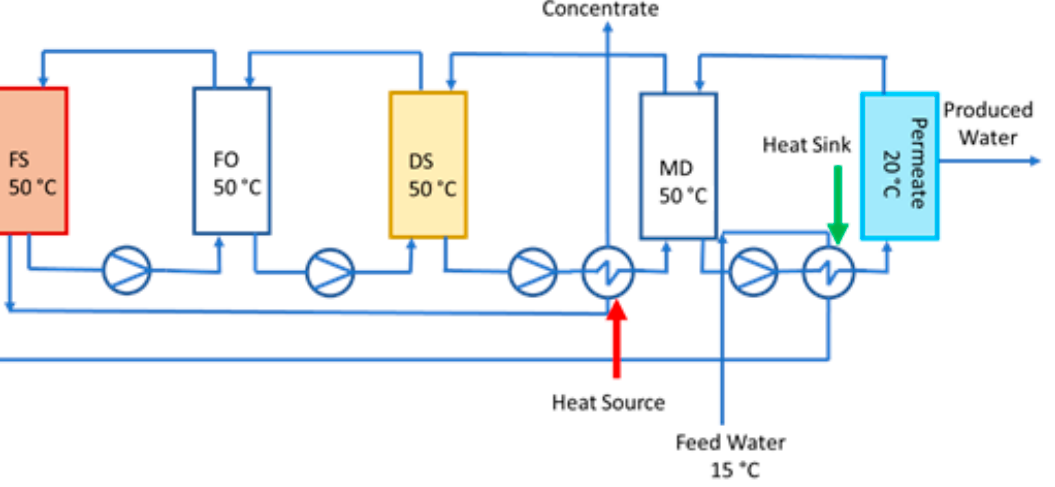
Figure 9. The proposed integrated FO-MD process for wastewater treatment and water production with internal heat recovery.